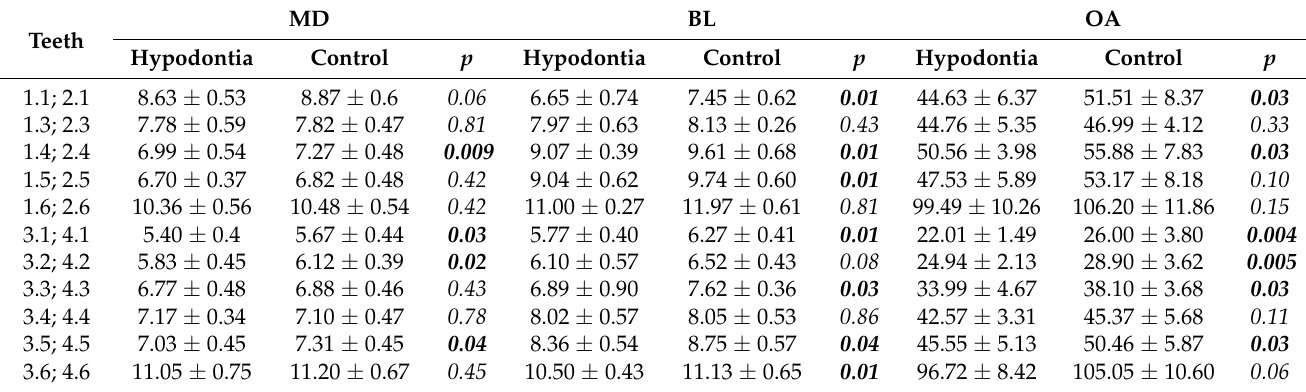
Table 3. Mean values and p values for statistical significance for the measured tooth